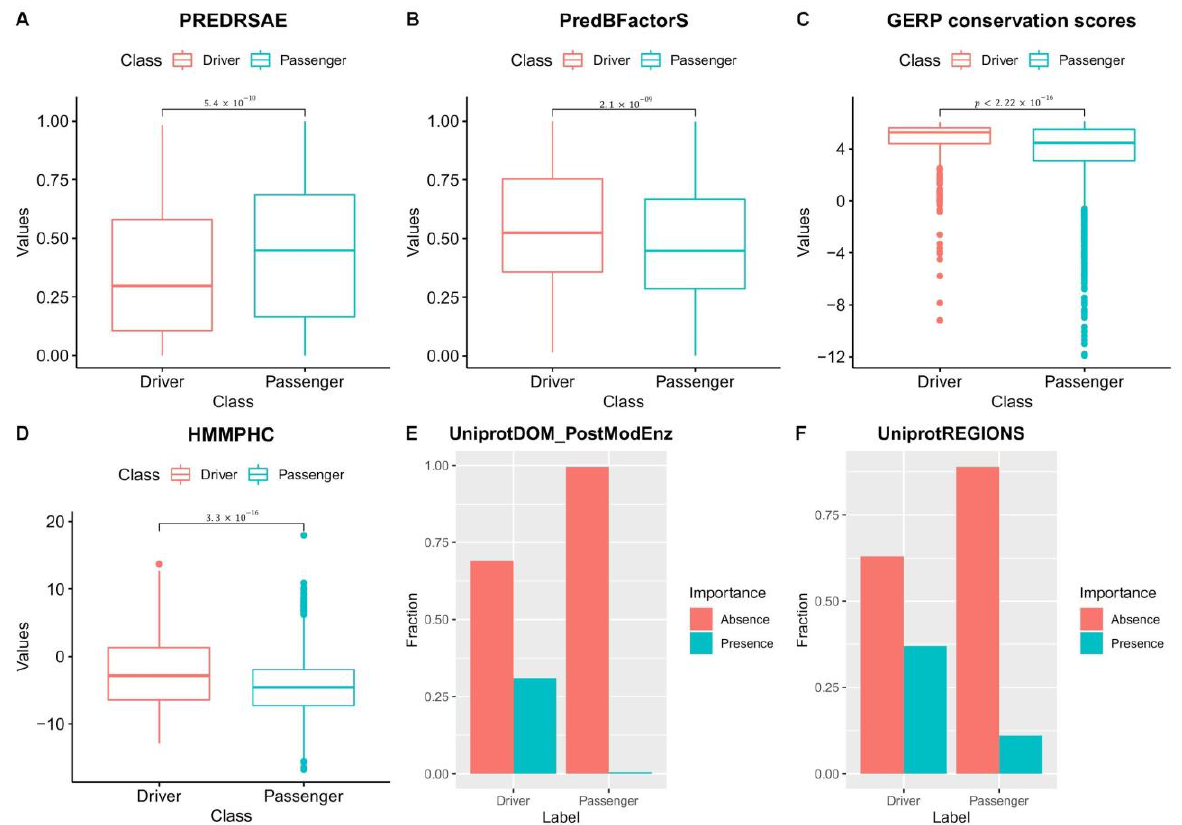
Figure 4. Class-wise distributional differences in features: Differences in the distribution of features between driver and passenger mutations observed from the training data used to derive NBDriver. ( A ) PREDRSAE (predicted residue solvent accessibility—exposed) gives the probability of the wild-type residue being exposed. From the plot, it is clear that the probability of driver mutations occurring in residues that are exposed is significantly less (Wilcoxon test; p = 5.4 × 10 − 10 ) than that of passengers. ( B ) PredBFactorS (high predicted Bfactor) gives the probability that the wild-type residue backbone is stiff. From the plot, it is clear that the probability of driver mutations occurring in residues with stiff backbones is significantly higher (Wilcoxon test; p = 2.1 × 10 − 9 ) than that of passengers. ( C ) GERP conservation scores provide the evolutionary conservativeness scores for specific sites where mutations have occurred. From the plot, it is clear that driver mutations occur in sites with GERP scores that are significantly higher (Wilcoxon test; p < 2.22 × 10 − 16 ) than passenger mutations. ( D ) HMMPHC (positional hidden Markov model (HMM) conservation score) is a measure that is calculated on the basis of the degree of conservation of the residue, the mutation, and the most probable amino acid. From the plot, it is clear that driver mutations tend to occur in residues with HMMPHC scores significantly higher (Wilcoxon test; p = 3.3 × 10 − 16 ) than passenger mutations. ( E ) UniprotDOM_PostModEnz is a feature based on protein domain knowledge that tells us whether a site in an enzymatic domain is responsible for any kind of post-translational modification (or PTM). Presence indicates that the mutation occurs in a site responsible for PTM and vice versa. From the plot, it is clear that more driver mutations occur in PTM-associated sites as compared to passengers. ( F ) UniprotREGIONS is a binary variable that tells us whether a mutation occurs in a region of interest in the protein sequence. Presence indicates that the mutation occurs in a region of interest and vice versa. From the plot, it is clear that more driver mutations cluster in regions of interest in the protein sequence than passengers, thereby making them mechanistically influential for the progression of the